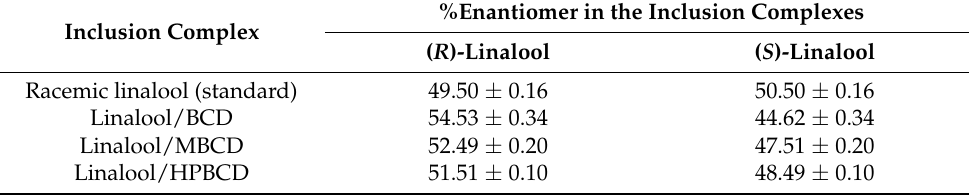
Table 6. Enantiomeric selection of linalool by